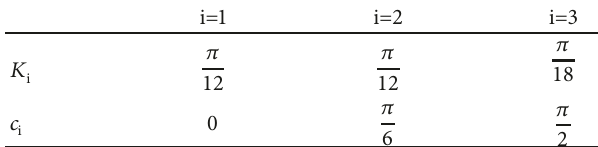
Table 4: the value of 𝐾 i and 𝑐 i .